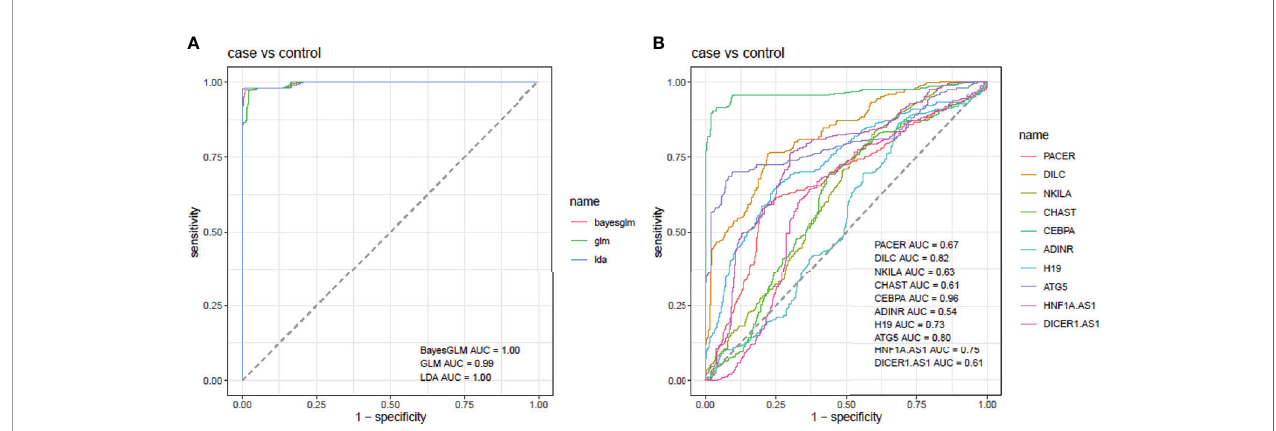
FIGURE 4 | ROC curves for assessment of diagnostic power of these genes using three distinctive models (A) . Assessment of diagnostic values of NF- k B-related genes in PD using Bayesian GLM